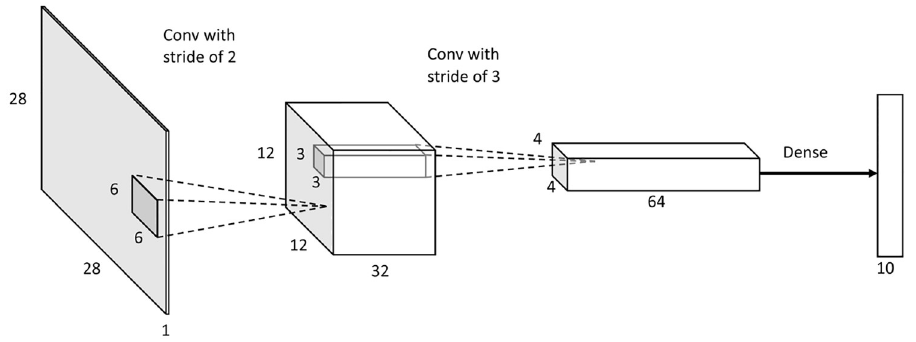
Fig 2. Architecture of our best